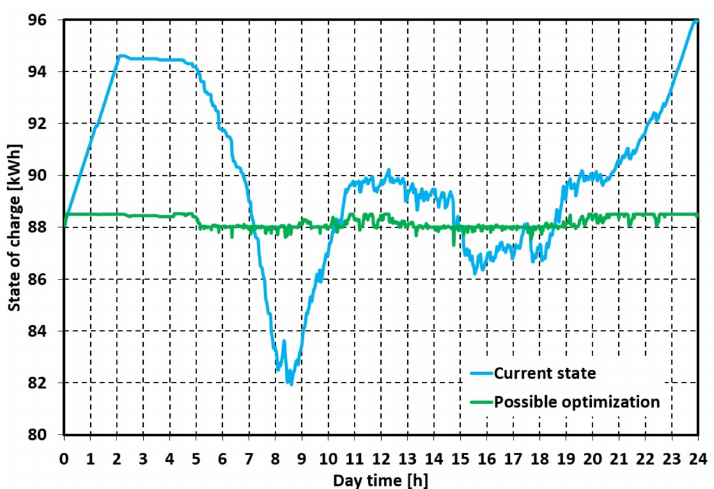
Figure 7. State of charge of the BS battery with present charging control algorithm (blue) and after optimization